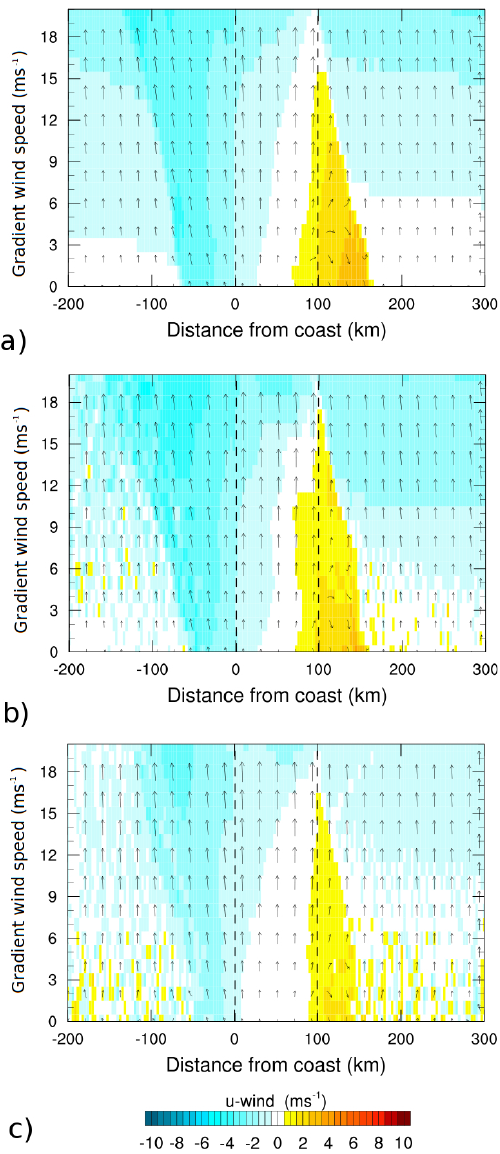
Fig. 22. Variations of 10m u-wind component (colour) with 10m wind vectors (arrows) for increasing south-north gradient winds at 17:00UTC using the (a) YSU, (b) MYJ and (c) MYNN PBL schemes. Coriolis acceleration is enabled for a latitude of 52° and distances are measured from the western coast. The SST was set at 287K for all simulations.